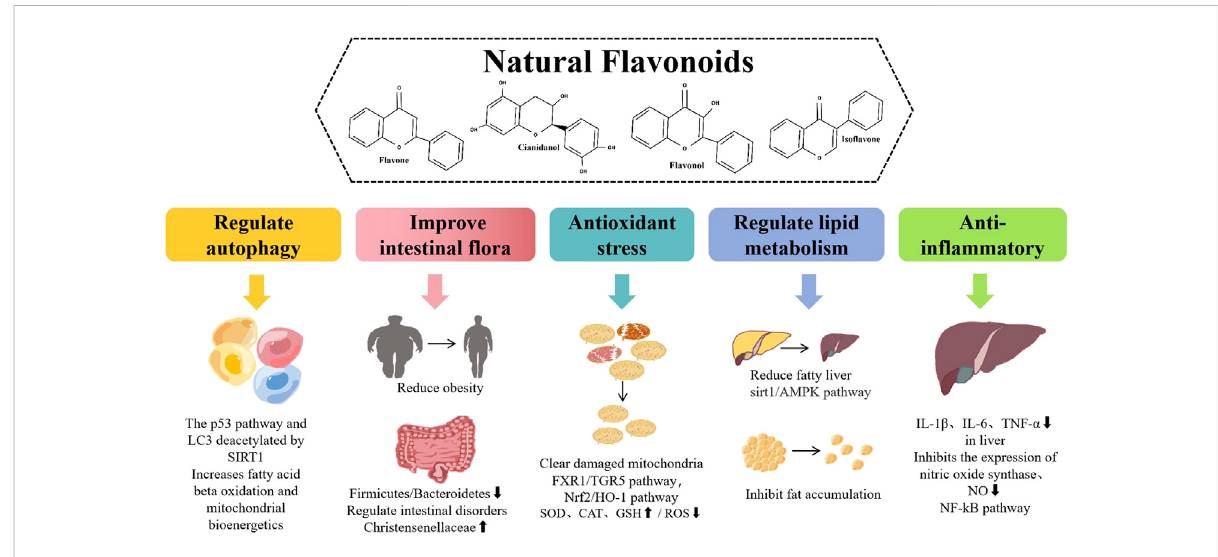
Different pharmacological effects and different mechanisms of natural fl avonoids for alleviating